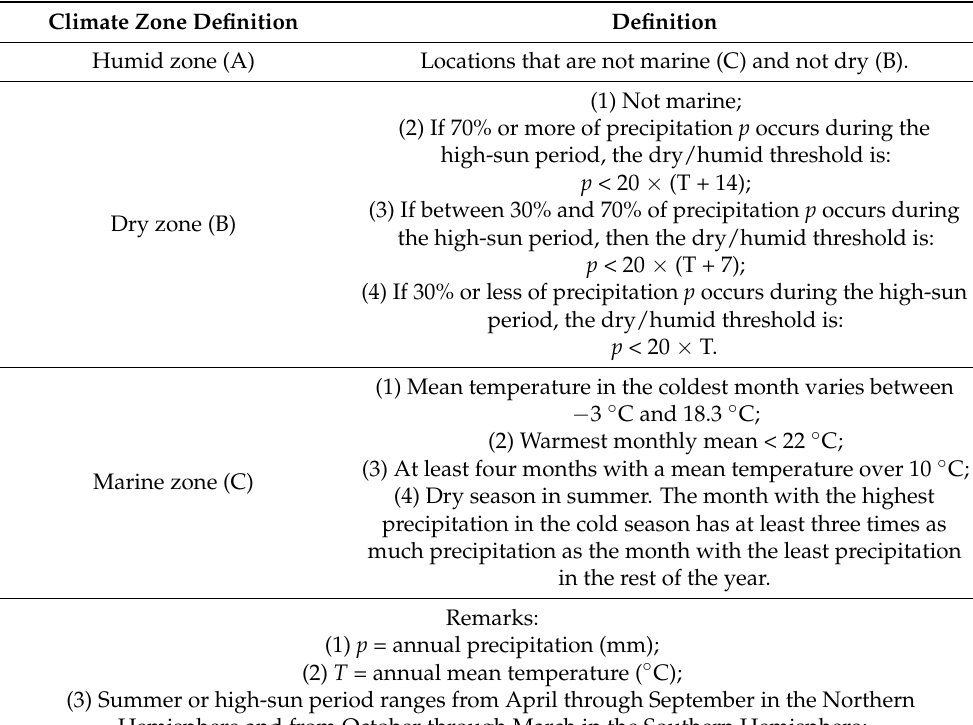
Table 1. Definitions of climate types in the ASHRAE standards [16–18].